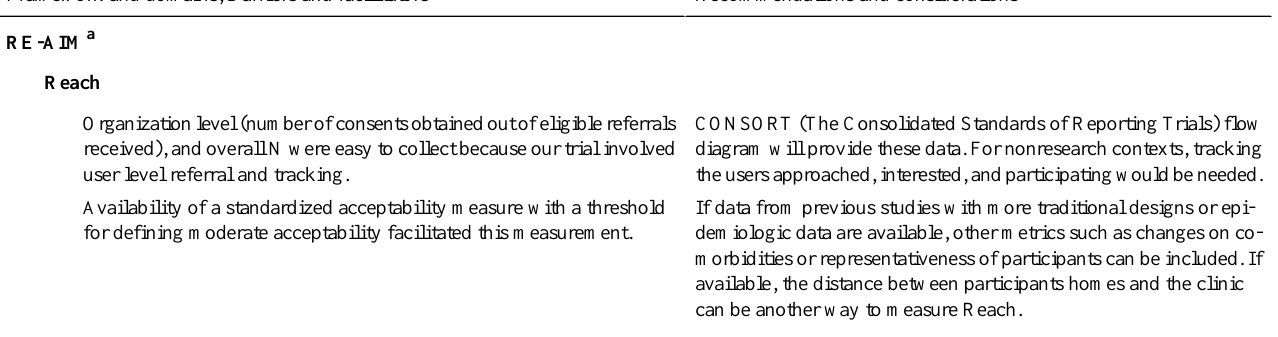
Recommendations and considerationsFramework and domains, Barriers and